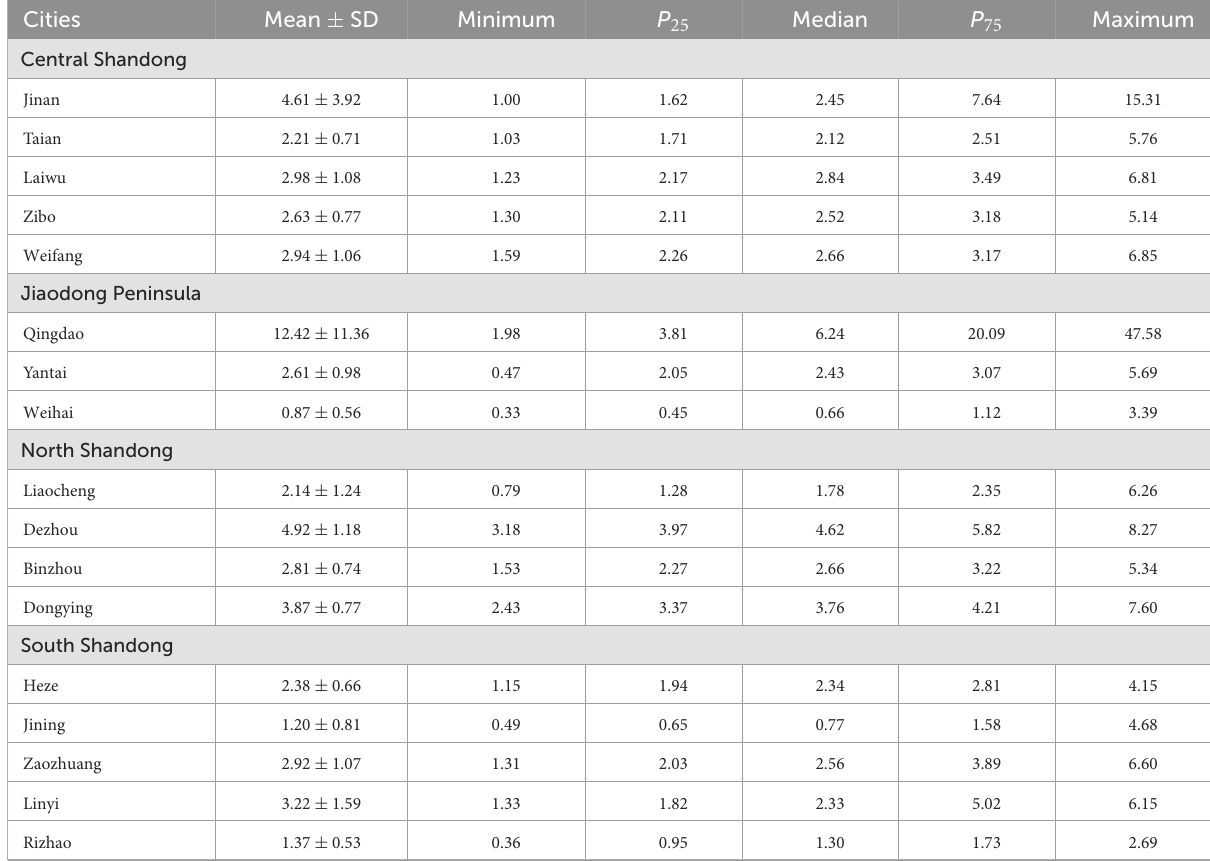
TABLE 1 Weekly incidence of influenza-like illness (%) in each city of Shandong, China during 2014–2017.